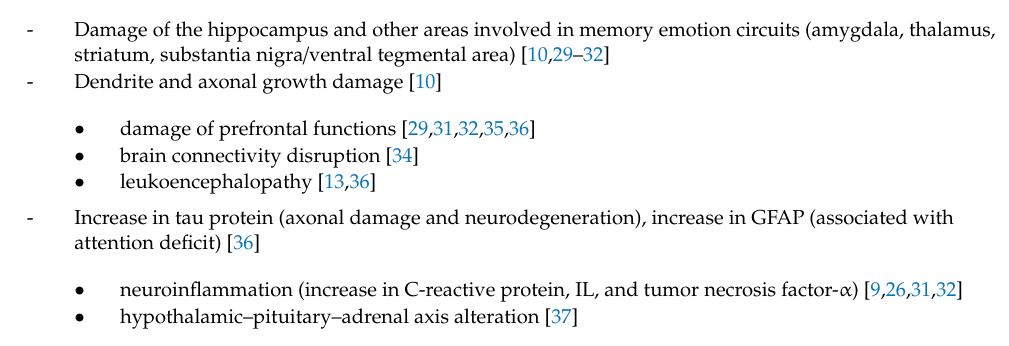
Table 1. Biological damage of the central nervous system observed in pediatric cancer.